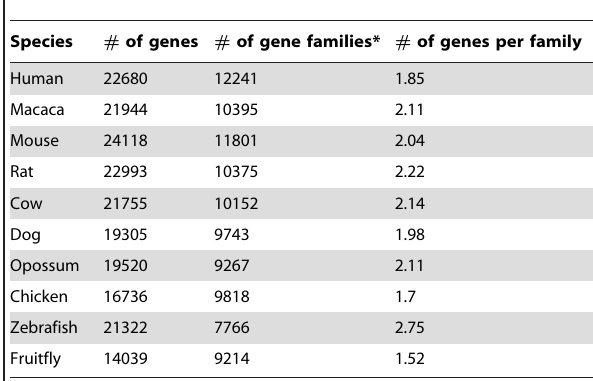
Table 1. General statistics of gene families in 10 animal species.